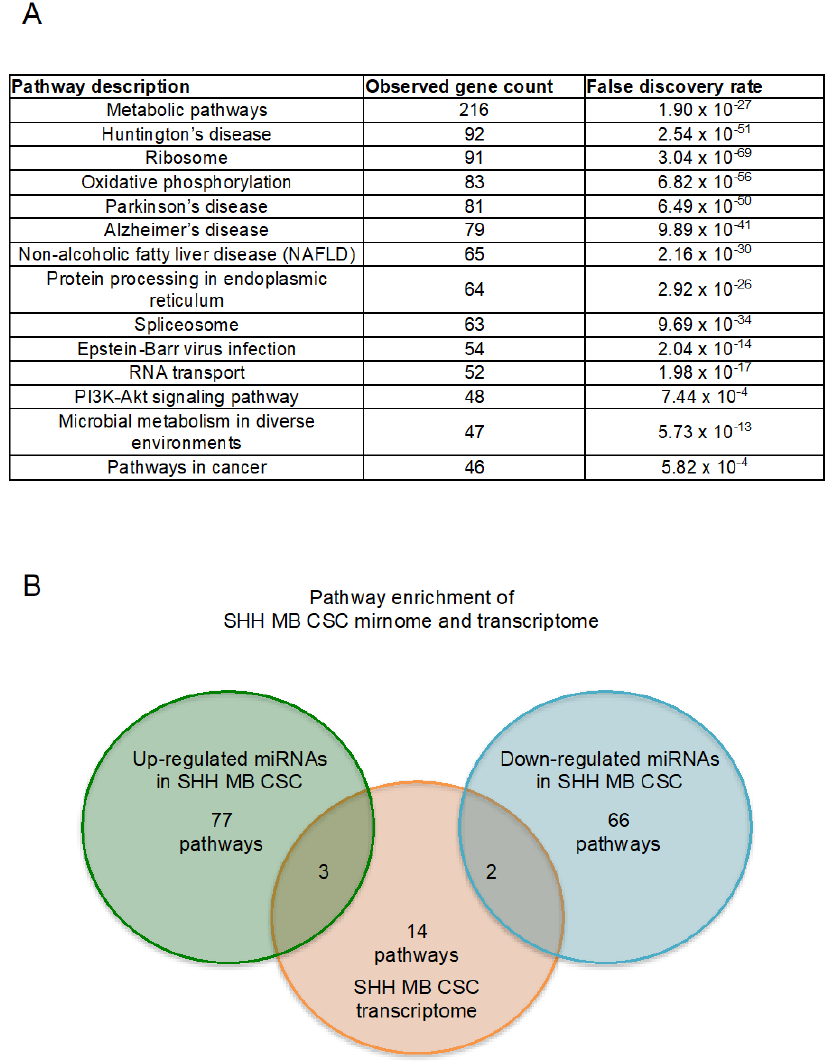
Figure 4. Enriched pathway analysis of SHH MB CSC transcriptome and mirnome. ( A ) Enriched pathways over-represented in the set of genes obtained through mRNA-sequencing of SHH MB CSCs *Findings are ranked according to observed gene count; ( B ) Venn diagram reporting the enriched pathways identified in SHH MB CSC up-regulated miRNAs, transcriptome and down-regulated miRNAs. (The enriched pathways identified in all three SHH MB CSC contexts are shown in Tables 3–5 and Tables S4–S6, respectively).